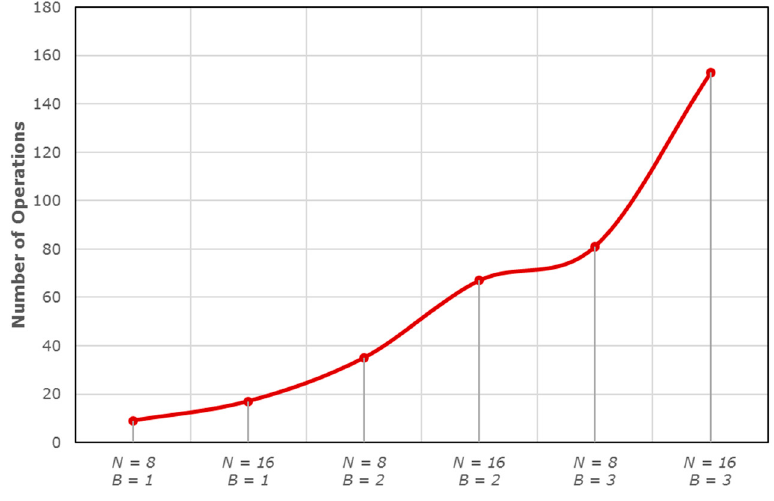
Figure 3. The number of operations ( Y -axis) required to solve the linear system Equation (6), by using different parameters ( X -axis).